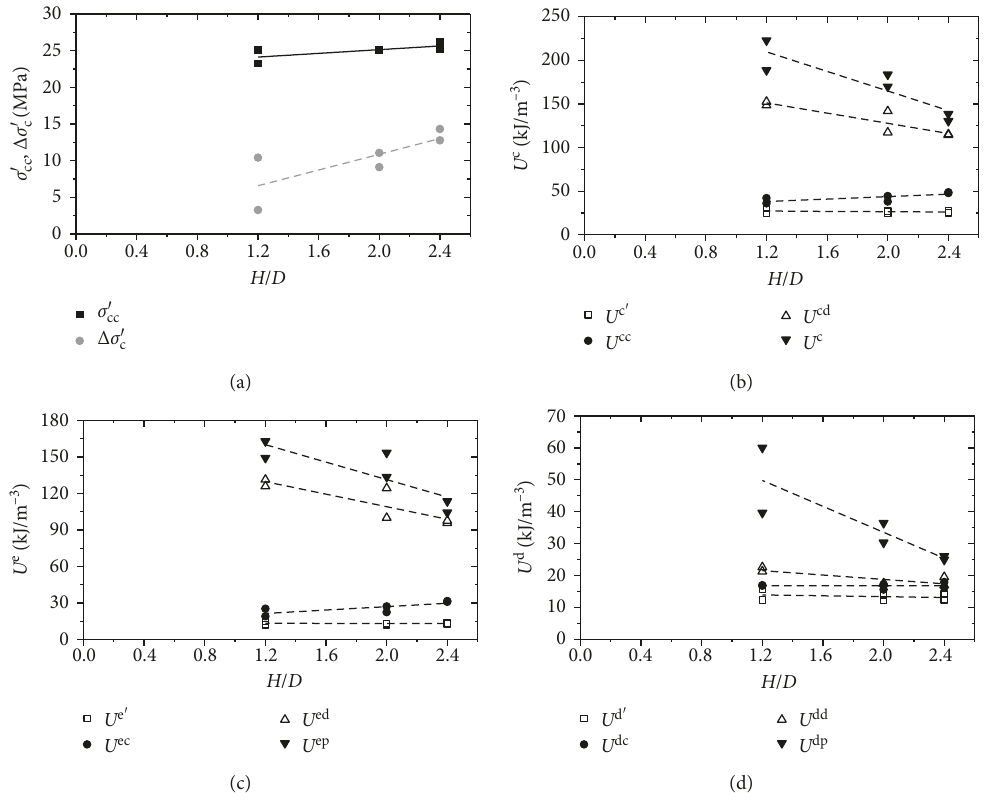
Figure 10: (a) Relationship among σ elastic energy density and H / D ; (d) relationship between dissipative energy density and H / D